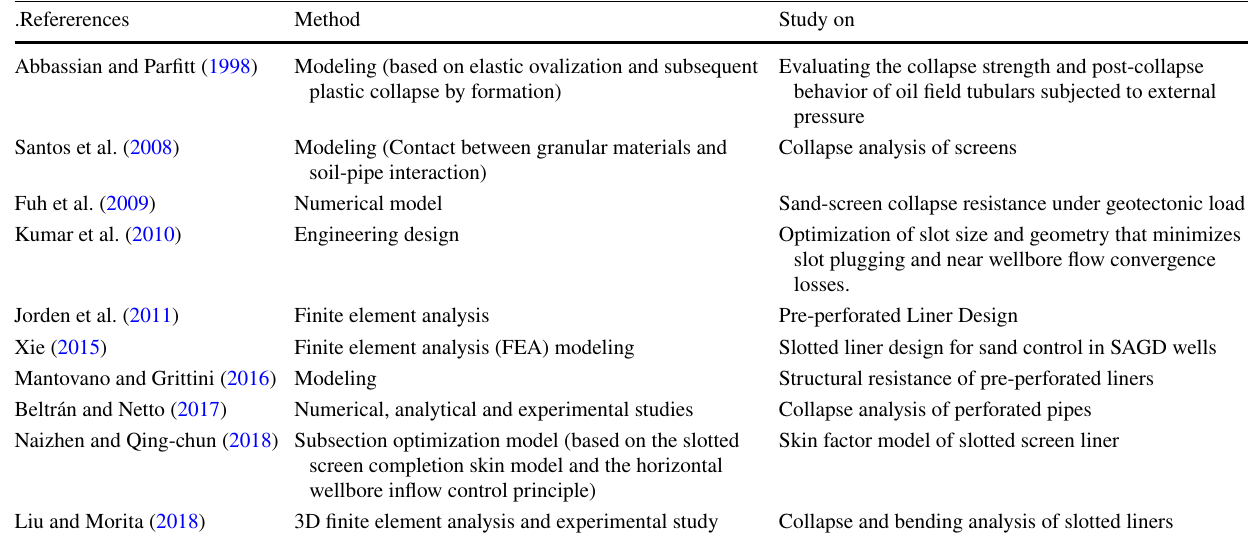
Table 1 Review of previous studies on perforated/slotted liner